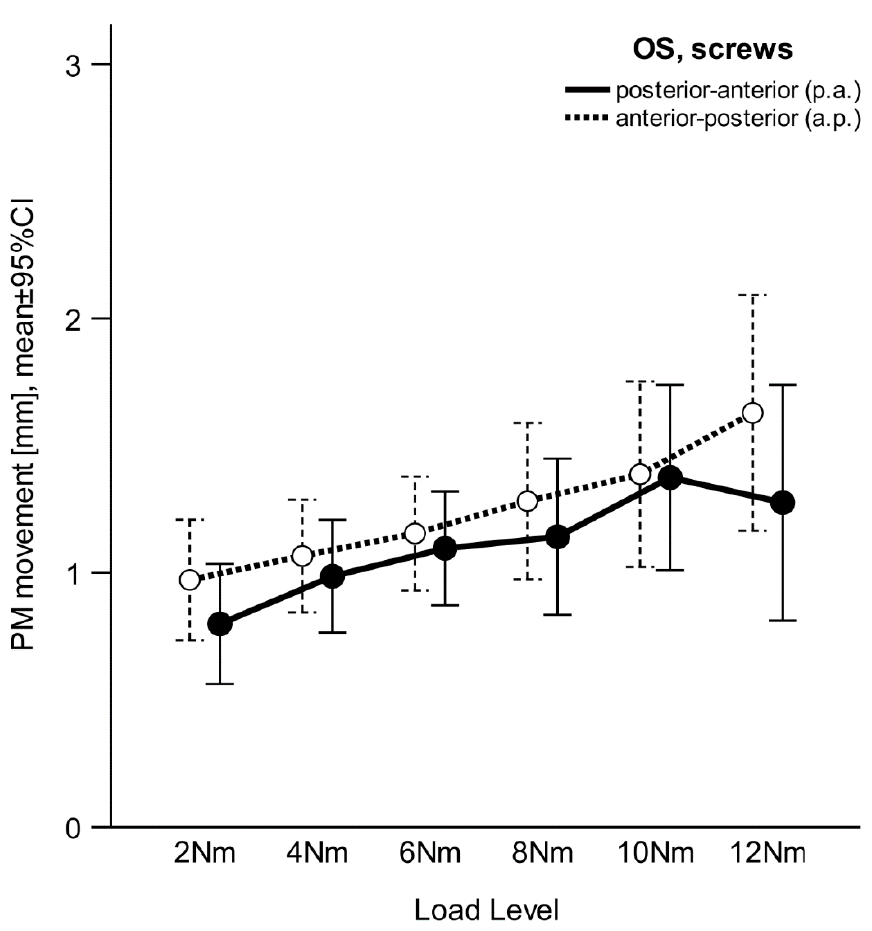
Figure 3. Movement of the posterior malleolus — Volkmann triangle — (PM) during load levels of 2 Nm to 12 Nm after osteosynthesis (OS) using posterior-anterior screws or anterior-posterior screws.